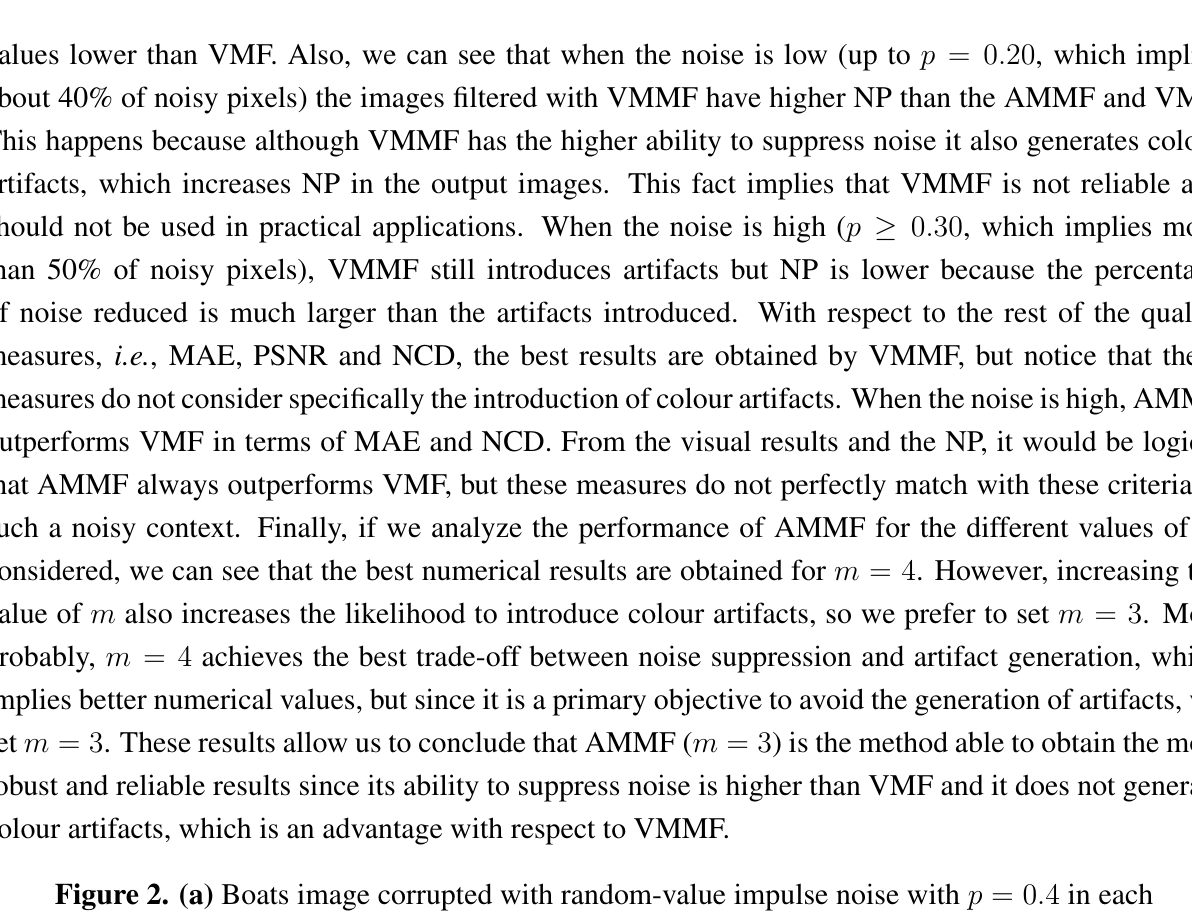
Figure 2. (a) Boats image corrupted with random-value impulse noise with p = 0 : 4 in each colour channel and outputs from: (b) VMMF, (c) VMF and (d) proposed AMMF.